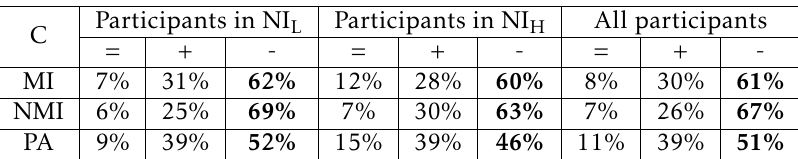
Table 8. Percentages of participants with an unchanged (=), increased (+) and decreased (-) value of w under different nudging conditions (C). Participants in NI L Participants in NI H All C